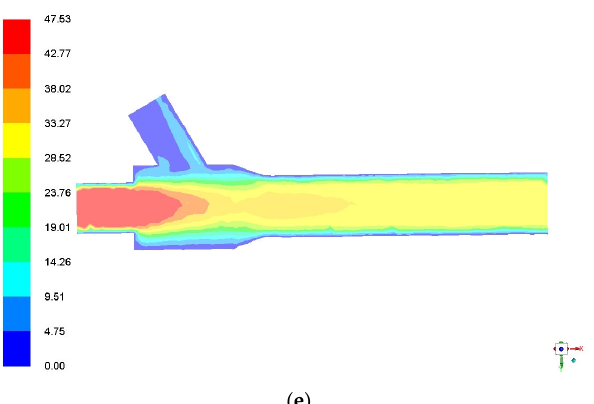
Figure 8. Variation of airflow field in venturi tube with different inlet air velocity: ( a ) 30 m/s; ( b ) 35 m/s; ( c ) 40 m/s; ( d ) 45 m/s; ( e ) 50 m/s.